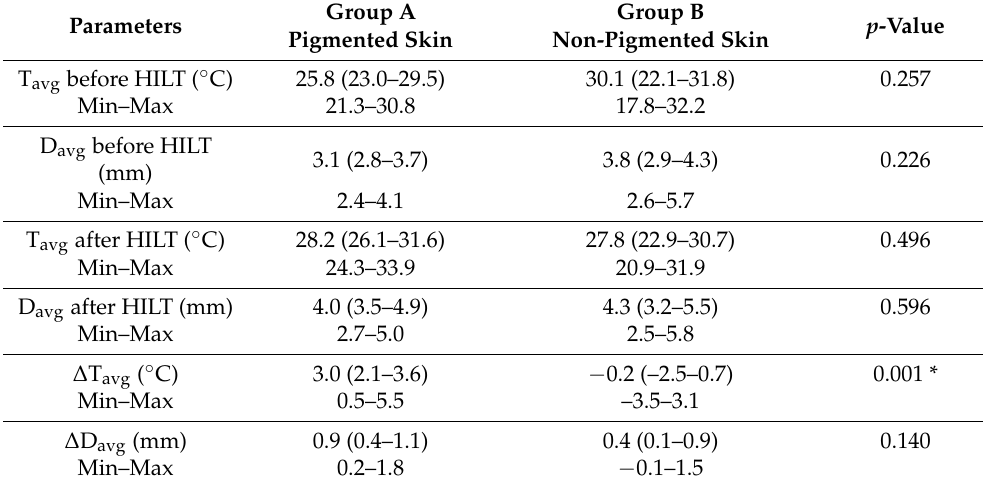
Table 1. Skin surface temperature, vein diameter and differences in values of skin surface temperature and vein diameter (median and IQR) before and after HILT application for horses from pigmented skin group (A) and non-pigmented skin group